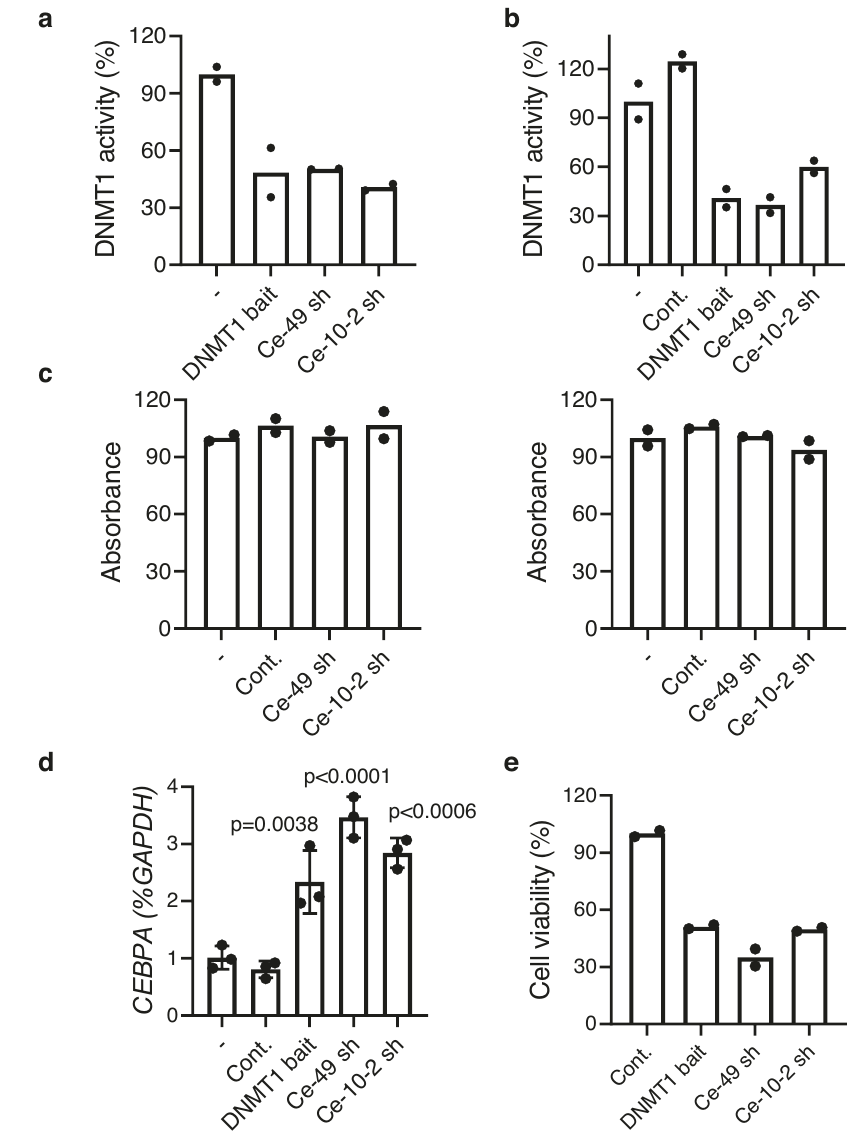
Fig. 5 | Functional activity of aptaDiRs. a Activity of puri fi ed DNMT1 protein was analyzed in vitro by DNMT1 inhibitor screening assay in the absence (-) or in the presenceofindicatedaptaDiRsorDNMT1bait.Resultsareexpressedaspercentage relative to the activity of DNMT1 protein alone. b DNMT1inhibitor screening assay was performed with nuclear extracts from K562 cells left untreated (-) or trans- fected with DNMT1 bait, indicated aptaDiRs or mutR5 used as a control (Cont.). Resultsareexpressedaspercentagerelativetotheactivitydetectedwithuntreated sample. c Activity of puri fi ed DNMT3A ( left ) or B ( right ) proteins was analyzed